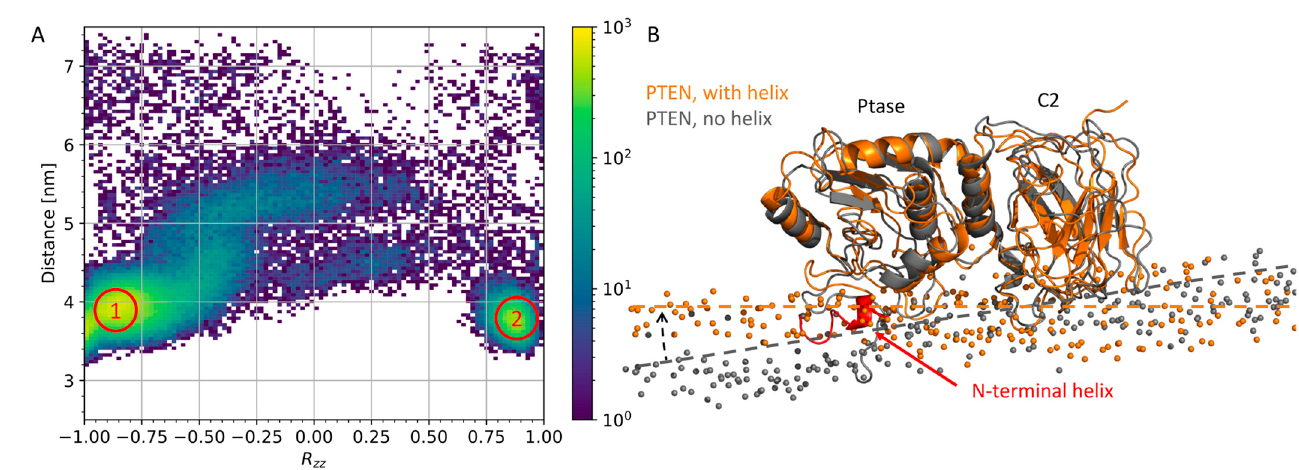
Figure 2. The role of the N-terminal helix of PTEN: ( A ) R zz vs protein–membrane center-of-mass distances for 25 repeats of coarse-grained simulations of full-length PTEN with N-terminal helix. Two binding modes were observed (red circles), with mode 1 being the productive mode, as shown in panel B, and mode 2 being unproductive, i.e., the active site of the Ptase domain was pointing away from the membrane (not shown). ( B ) Alignment of PTEN productive binding mode (orange, helix in red), with the productive mode of PTEN without the N-terminal helix (gray). Alignment was performed after conversion from coarse-grained to all-atom resolution. Bilayer planes are shown (dashed lines) together with phosphates from the lipid headgroups (spheres).